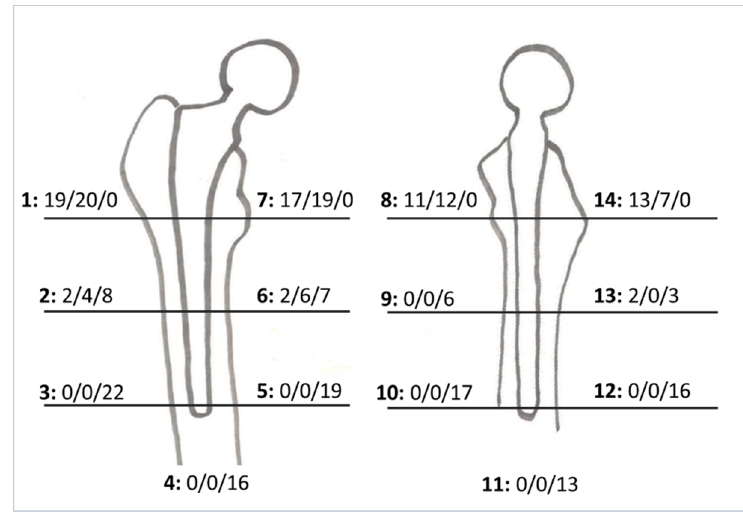
Figure 5. Radiographic assessment of the femoral stem according to Gruen zones 1 to 7 on anteri- or/posterior radiographs for 301 hips with complete available radiographic follow-up and zones 8 to 14 on lateral radiographs for 154 hips. In the figure, the numbers from left to right refer, respec- tively to: Gruen zone, number of hips with presence of radiolucency lines, number of hips with periprosthetic osteolysis, number of hips with cortical hypertrophy.